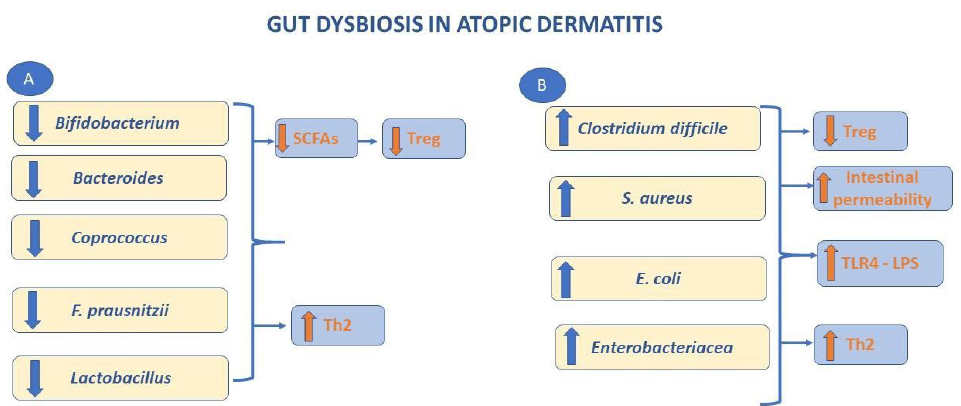
Figure 2. Gut dysbiosis in atopic dermatitis. The image shows gut microbial alteration in patients with AD. It seems that they have reduction of the beneficial microbes such as Lactobacillus, Bifidobacaterium ( A ) and an increase of the proportions of E. coli, C. difficile and S. aureus( B ). Metabolites of Bifidobacterium, Lactobacillus, etc. are able to suppress the expression of Th2 associated cytokines. The reduction of bacteria producing SCFAs leads to an inadequate production of Treg cells. E. coli can promote an intestinal inflammatory response thanks to LPS. C. difficile, S. aureus could be associated with increase of intestinal permeability and eosinophilic inflammation. AD: atopic dermatitis; SCFAs: short chain fatty acids; Treg: regulatory T; TLR4: tool like receptor 4; LPS: lipopolysaccharide.